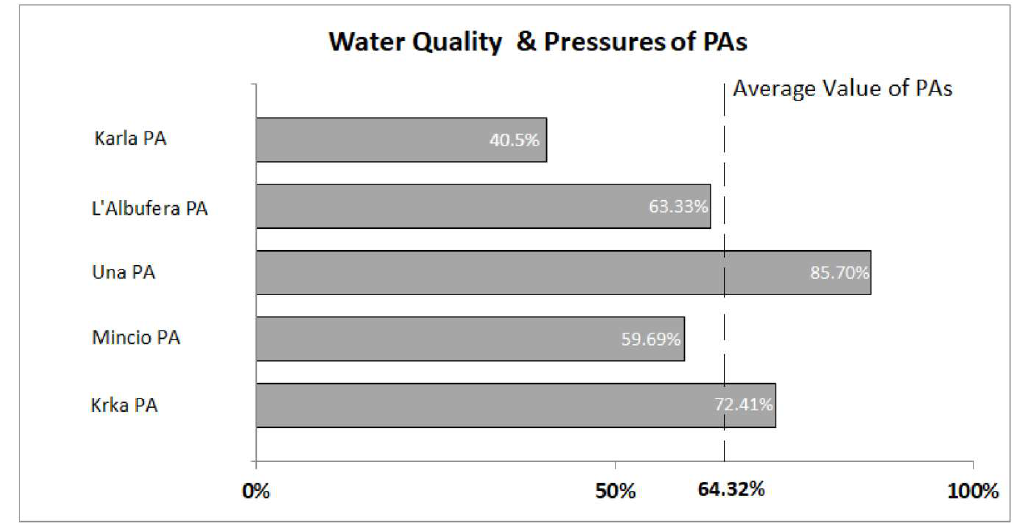
Figure 4. Gap rating on “Water Quality and Pressures” for each of the five PAs.